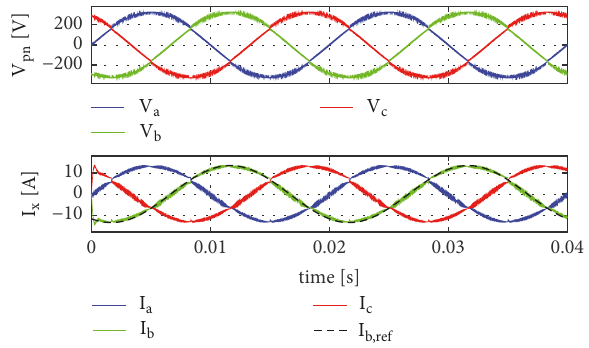
Figure 6: Phase voltages at the inverter terminals, injected phase currents, and reference current